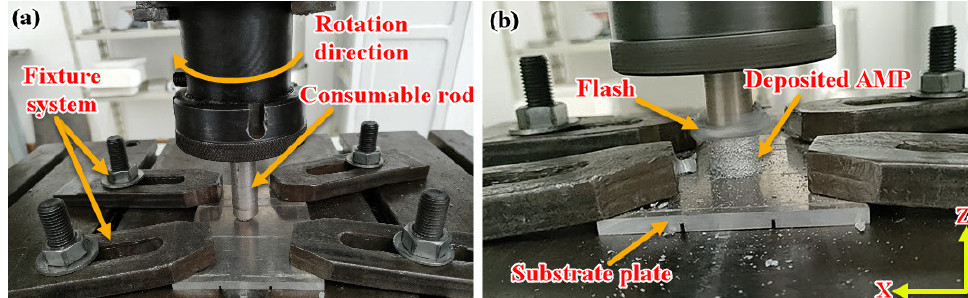
Figure 3 . Photo images showing ( a ) fixing the A356 consumable rod and substrate AA2024 on the FSW/FSP machine, ( b ) the process features of the AFS-D A356